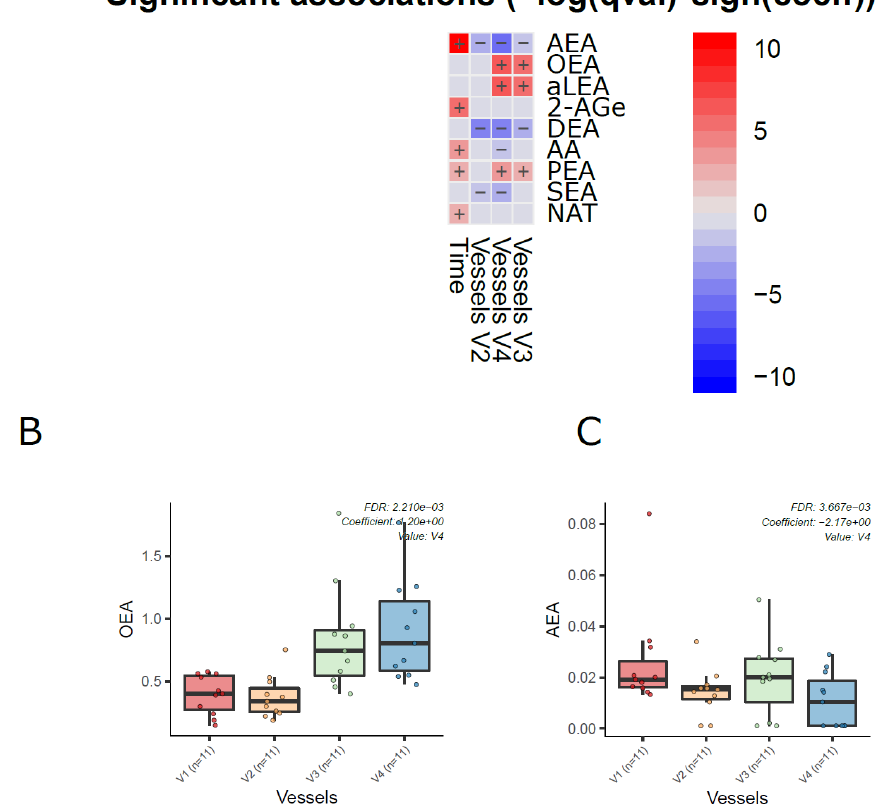
Figure 3. Dynamics of ECs in the in vitro colon simulator. The figure depicts the EC changes in four vessels (V1–V4) over two time points (24 and 48 h). ( A ) Heat map showing the difference in the EC between vessels (V1–V4), time (24 vs. 48 h), and case (with/without PDX) compared using a multivariable linear model. The changes in vessels were in reference to vessel 1. Blue indicates decreasing trend while red denotes an increase in the trend. ( B , C ) The box plot shows the difference in the EC between vessels (V1–V4). These selected ECs highlight the dynamic trends between the vessels (V1 to V4), which mimics the compartments of the human colon from the proximal to the distal part.